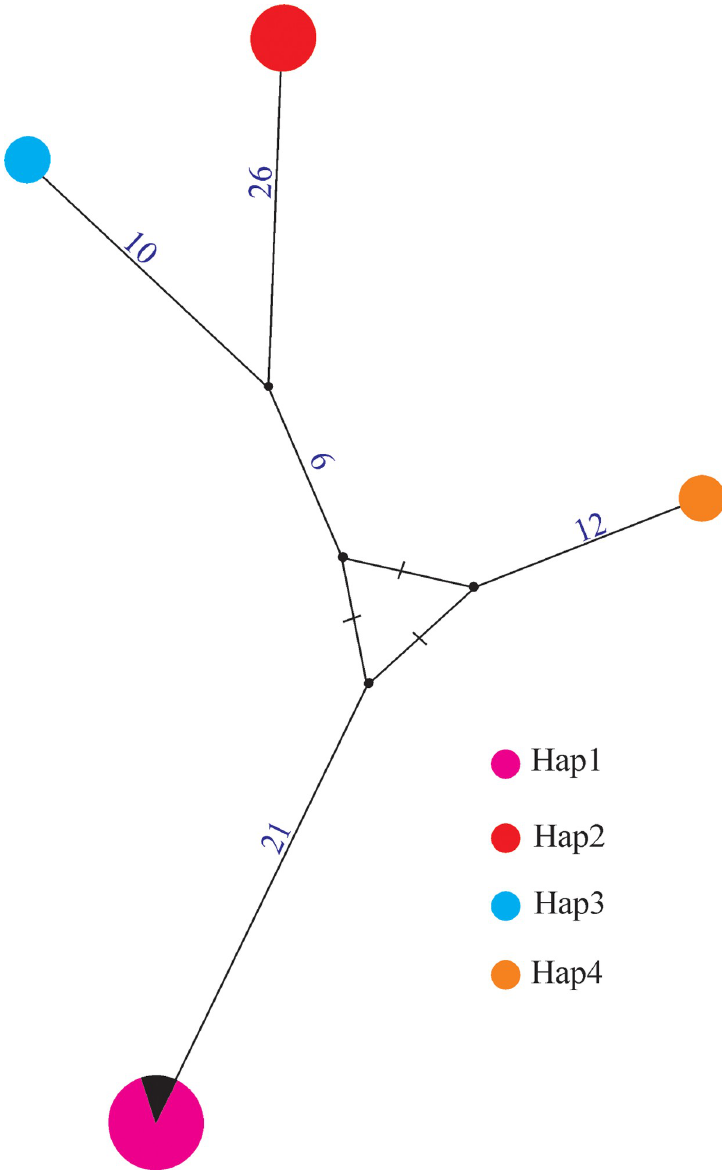
Fig 9. Minimum spanning network showing the relationships between haplotypes of five populations of Xiphinema afratakhtehnsis sp. nov. using COI mtDNA. Small black cycles represent missing haplotypes and the mutational steps are given on the branches.